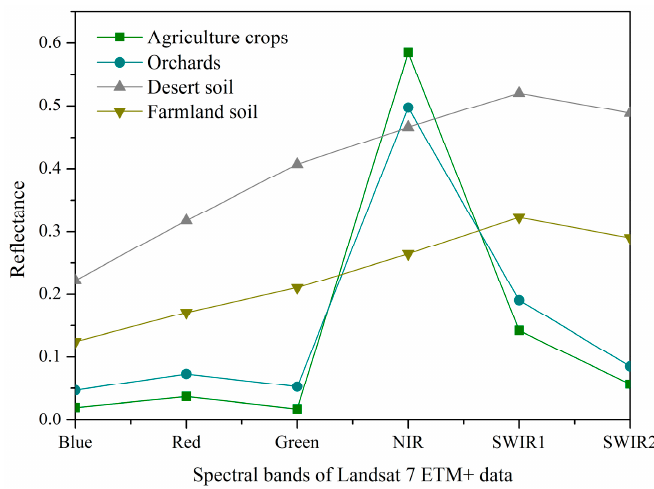
Figure 3. The spectral responses of the selected 4 endmembers for the SMA method.